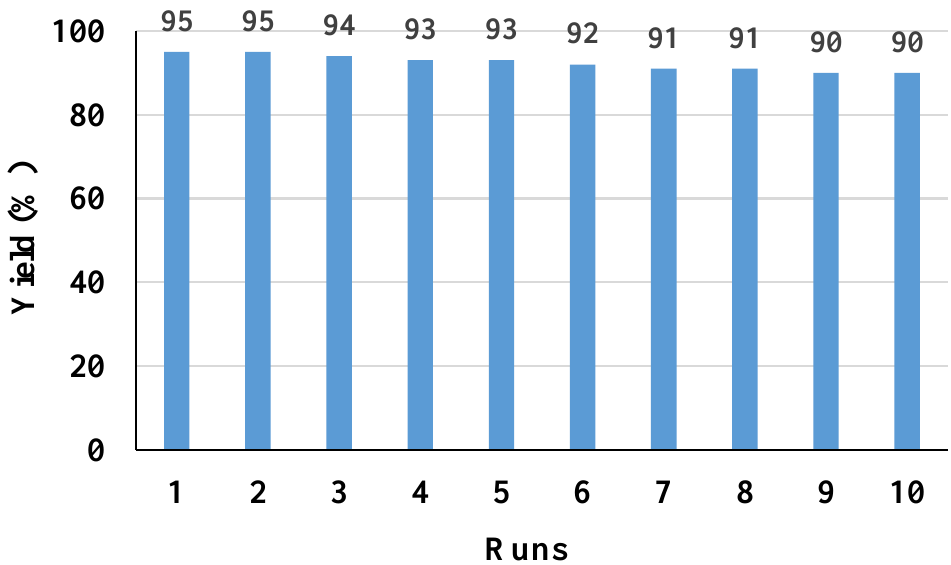
Figure 3. Recycling of Pd/H-MOR in the Suzuki coupling.